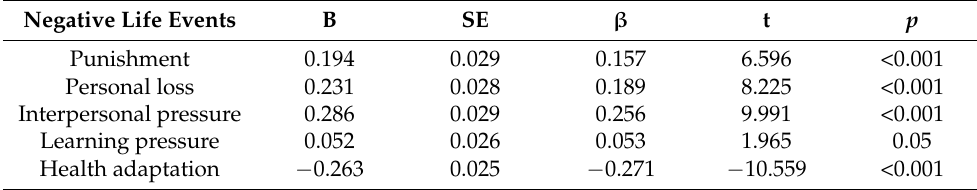
Table 5. Regression analysis of negative life events and somatization